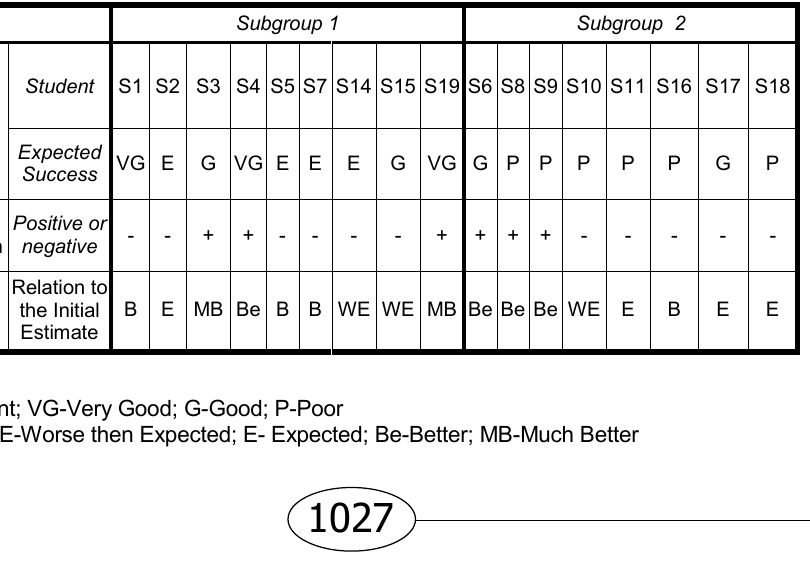
Table 5 – One Look at the Results Achieved Through the Monitoring of Motivational Factors During the Course Realization by a Simulated ITS Таблица 5 – Обзор результатов и наблюдение за изменениями мотивационного фактора в процессе проведения курса , путем моделирования